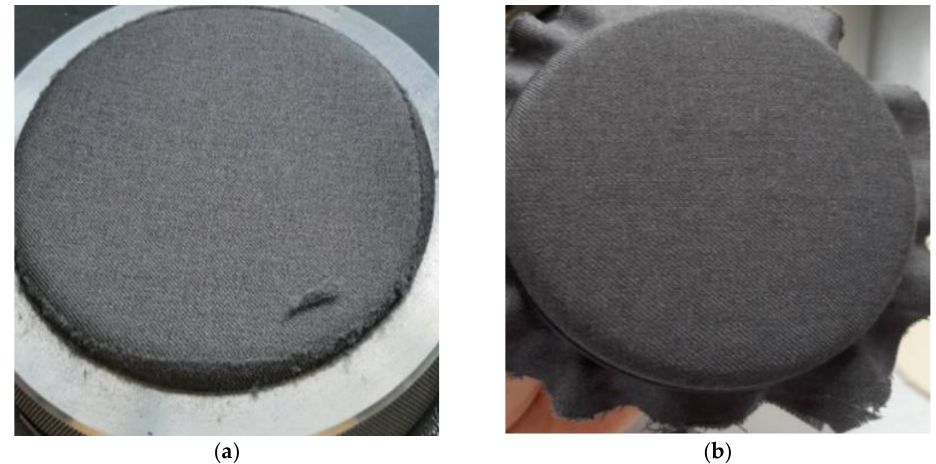
Figure 10. Samples of untreated fabric ( a ) and treated with a PUPXC6PW combination, ( b ) tested after 25,000 pilling cycles.